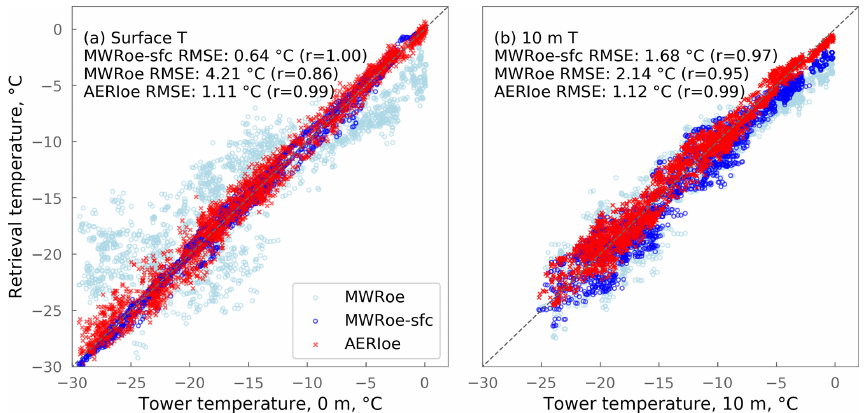
Figure 5. Retrieved temperature versus in-situ measurements from the tower at the surface (a) and 10m (b) . The MWRoe retrievals are plotted as pale blue circles, the AERIoe retrievals as red crosses, and the MWRoe retrievals that are constrained by the surface temperature (MWRoe-sfc) are dark blue circles. The Pearson’s correlation coefficient ( r ) and root-mean-squared error (RMSE) between each set of retrievals and the tower measurements are included on the figure. All correlations are significant at the 99% confidence level. The dashed grey line represents perfect